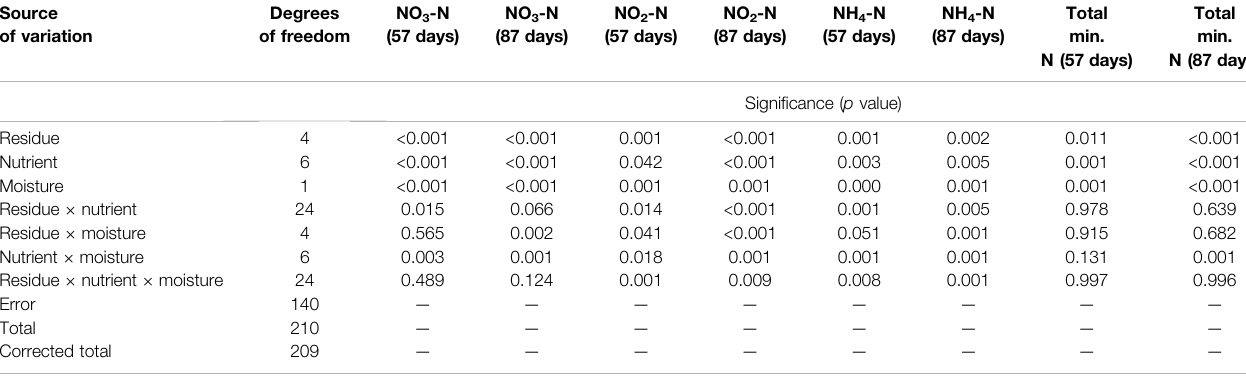
TABLE 2 | ANOVA for nitrate N, Nitrite N, ammonical N, and total mineral N at 57 and 87 days of incubation. Source of variation